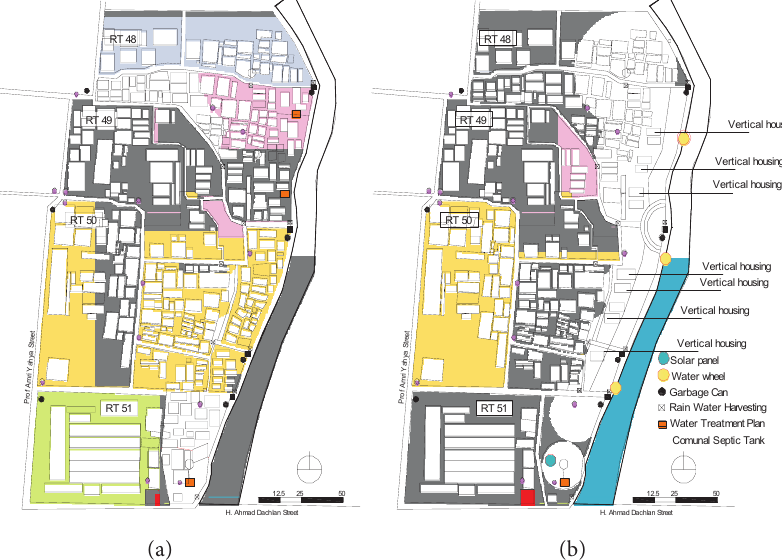
Figure 4. (a) The existing ground floor area; (b) The planned ground floor area after